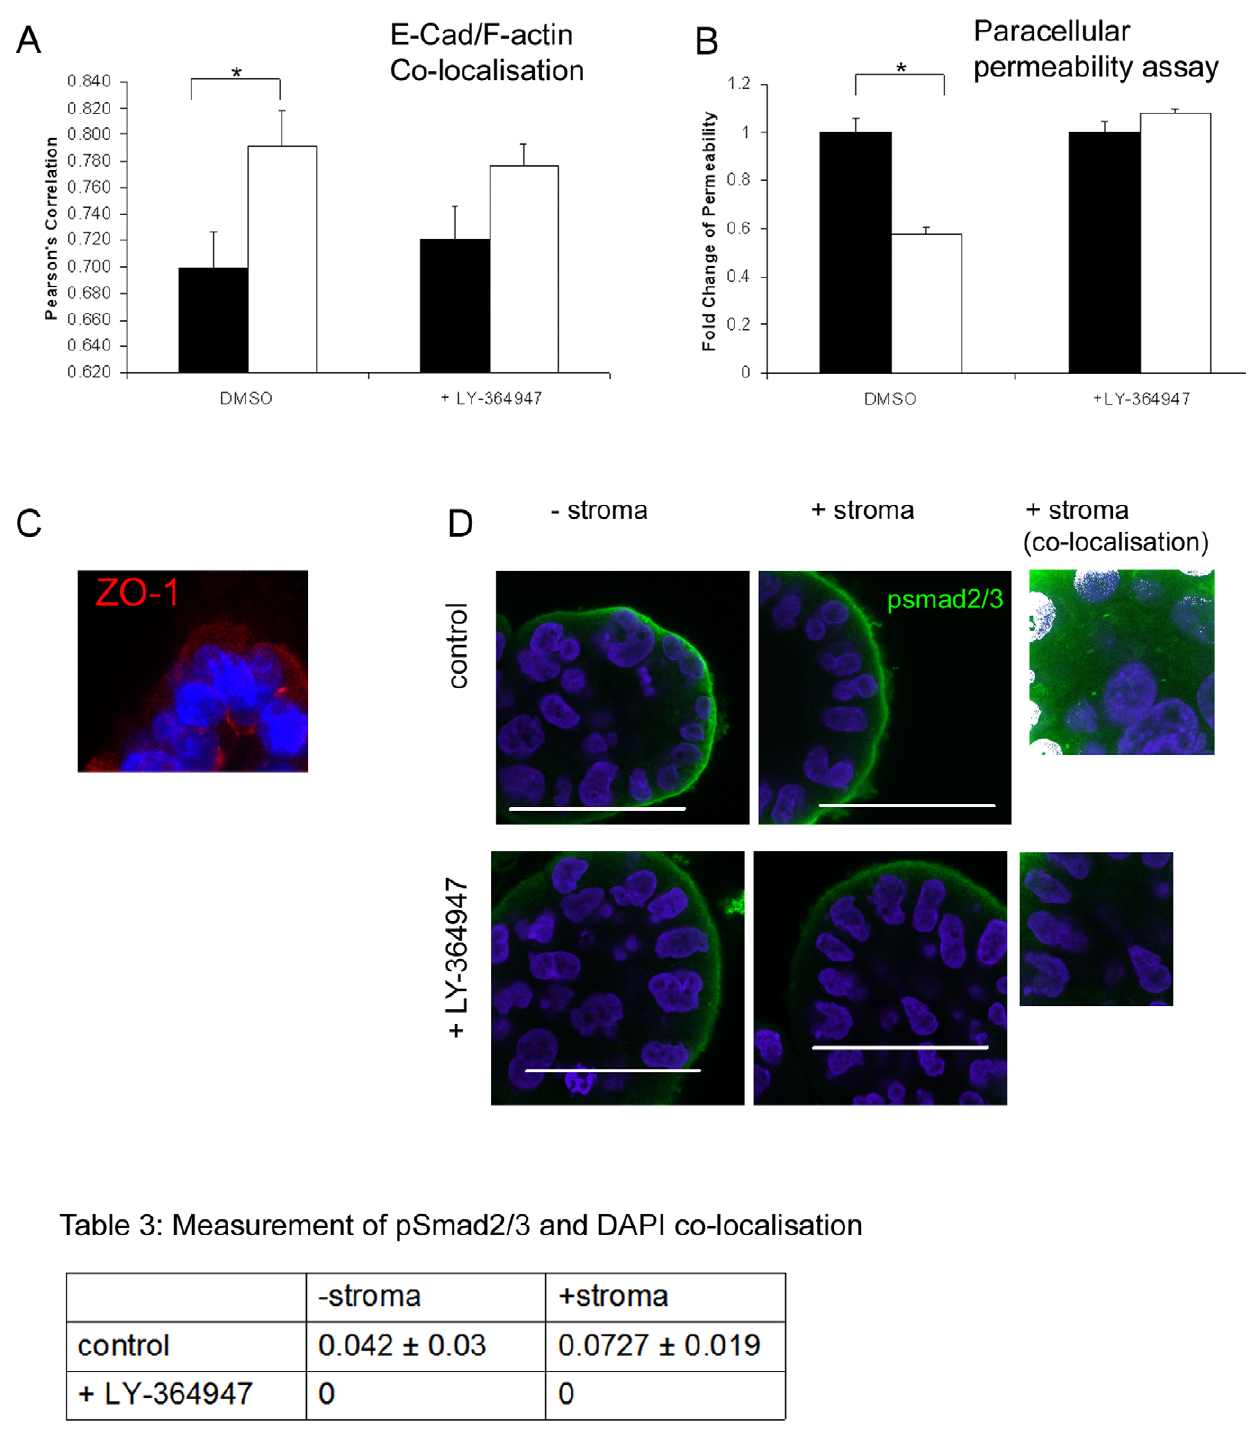
Figure 6. Inhibition of TGF b signalling disrupts E-cadherin and F-actin co-localisation and cell to cell adhesion. 3D BPH-1 acini were cultured for 7 days in the presence (white bars) or absence of stroma (black bars). Both conditions were treated with 500 nM LY-364947 or DMSO for 7 days. (A). E-cadherin and F-actin co-localisation (n=10) was measured and the Pearson’s correlation plotted *p , 0.05. (B). A paracellular permeability assay measured the ability of 70 kDa dextran to diffuse into the lumen of 3D acini. Six wells were measured per assay and the results are representative of two experiments cultured with 2 different stroma. (C). Mid-section of BPH-1 3D acini immunostained for ZO-1 (red), DAPI (blue). Intense staining can be seen at the luminal and lateral membranes. (D) Confocal images of the expression of pSmad 2/3 after 7 days growth. Nuclear staining was not visible without refocusing and recalibrating the confocal microscope away from the basal membrane ( + stroma co-localization). Nuclear co-localisation (white) of pSmad 2/3 (green) and DAPI (blue) was only found in the absence of LY-364947. Table 3. Co-localisation was measured (as above) and calculated using Volocity software to obtain the Pearson’s correlation (n=4). All nuclear images were taken at equivalent settings to compare green and blue co-localisation.